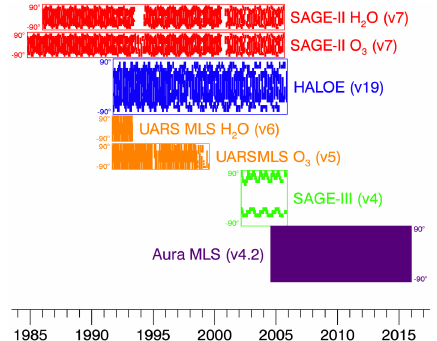
Figure 1. Temporal and latitudinal coverage of satellite data used as input to SWOOSH. The boxes surrounding each data set span 90 ◦ S–90 ◦ N in the vertical. Data are filled for each month and 10 ◦ latitude band containing valid data. Where significant coverage dif- ferences exist for WV and O 3 for a given satellite, the coverage is plotted